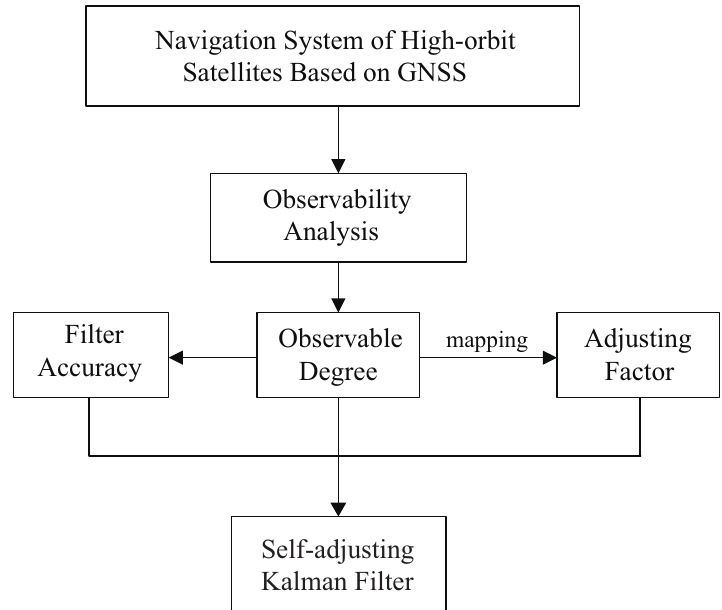
Figure 1. The framework of navigation filter optimization algorithm proposed in the